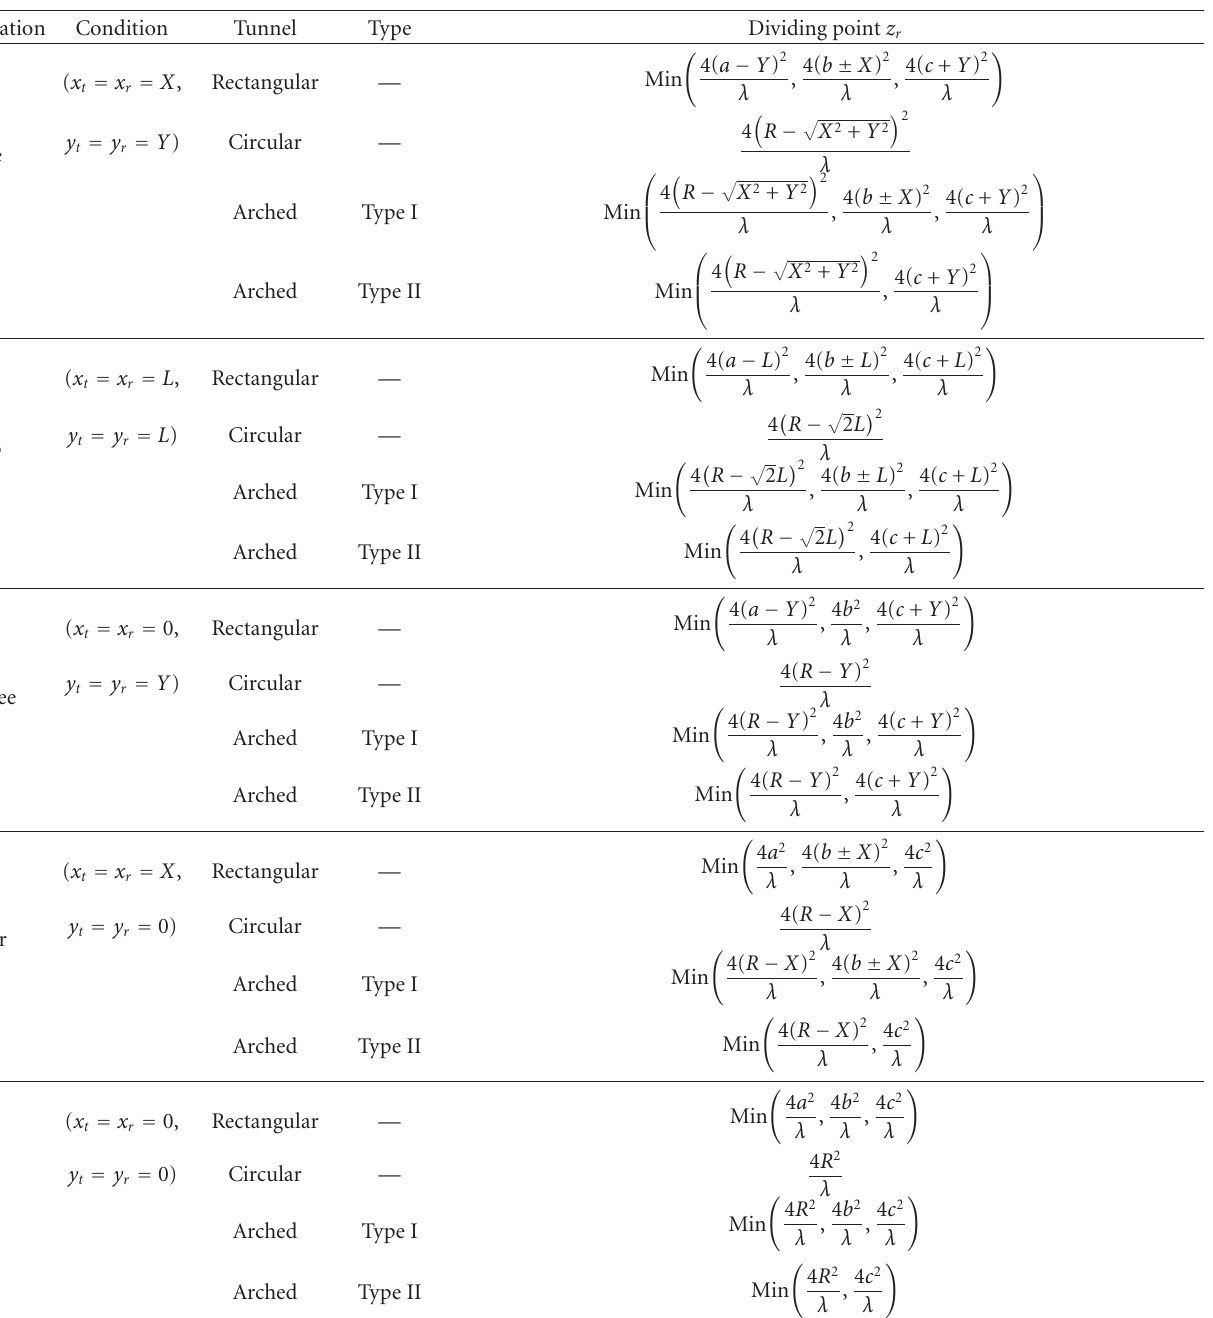
Table 2: Simplification of the dividing point model in certain specific